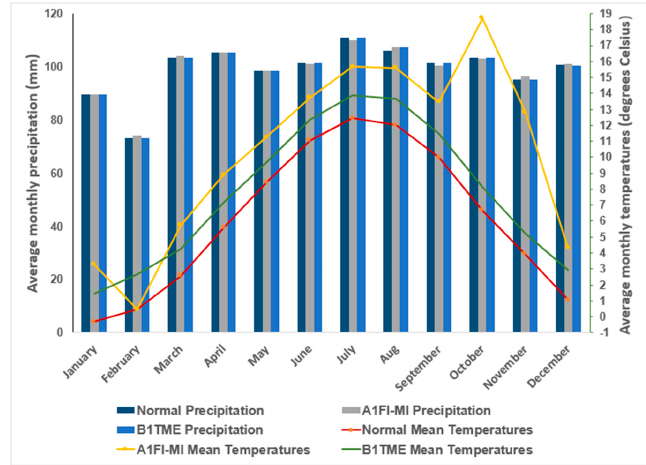
Figure 4. Thirty-year normal average monthly precipitation and temperatures and projected using A1FI-MI and B1TME scenarios.